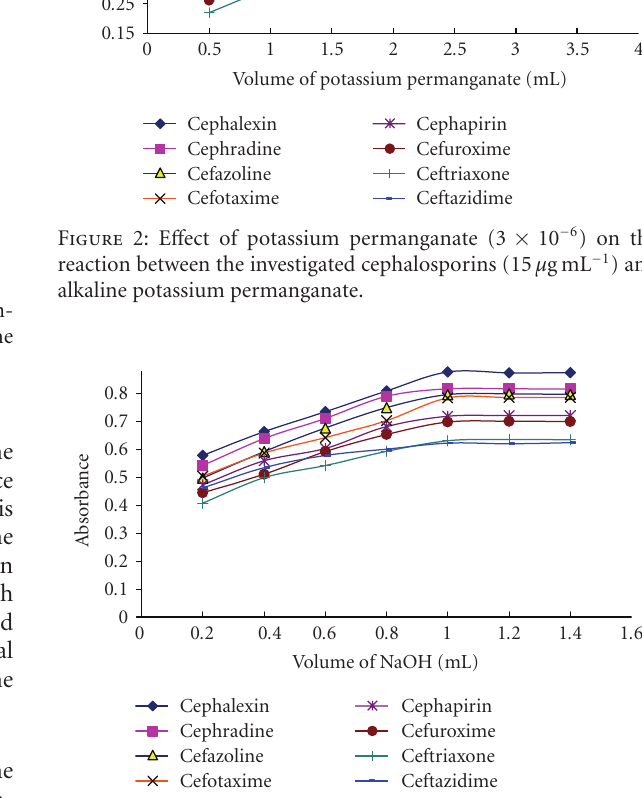
Figure 3: E ff ect of sodium hydroxide concentration (0.75M) on the reaction between the investigated cephalosporins (15 μ gmL − 1 ) and alkaline potassium